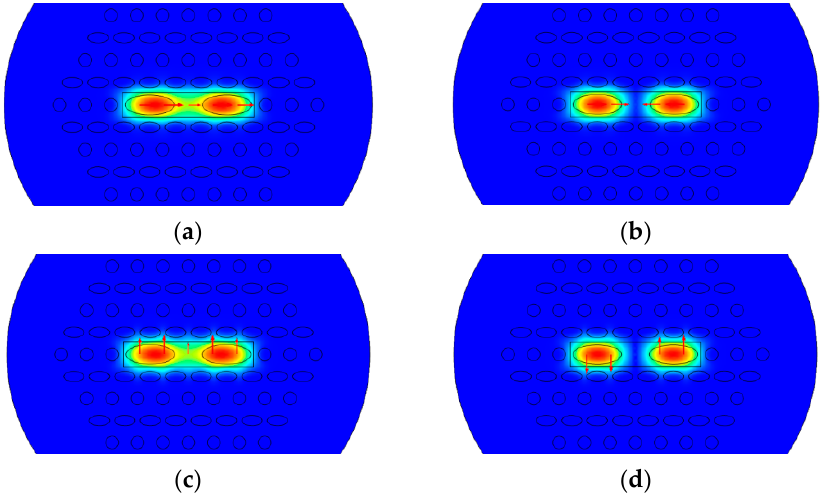
Figure 3. Electric field of four fundamental supermodes in the proposed dual-core PCF. The arrows indicate the direction of the electric field vectors. ( a ) x polarize even mode, ( b ) x polarize odd mode, ( c ) y polarize even mode, and ( d ) y polarize odd mode.